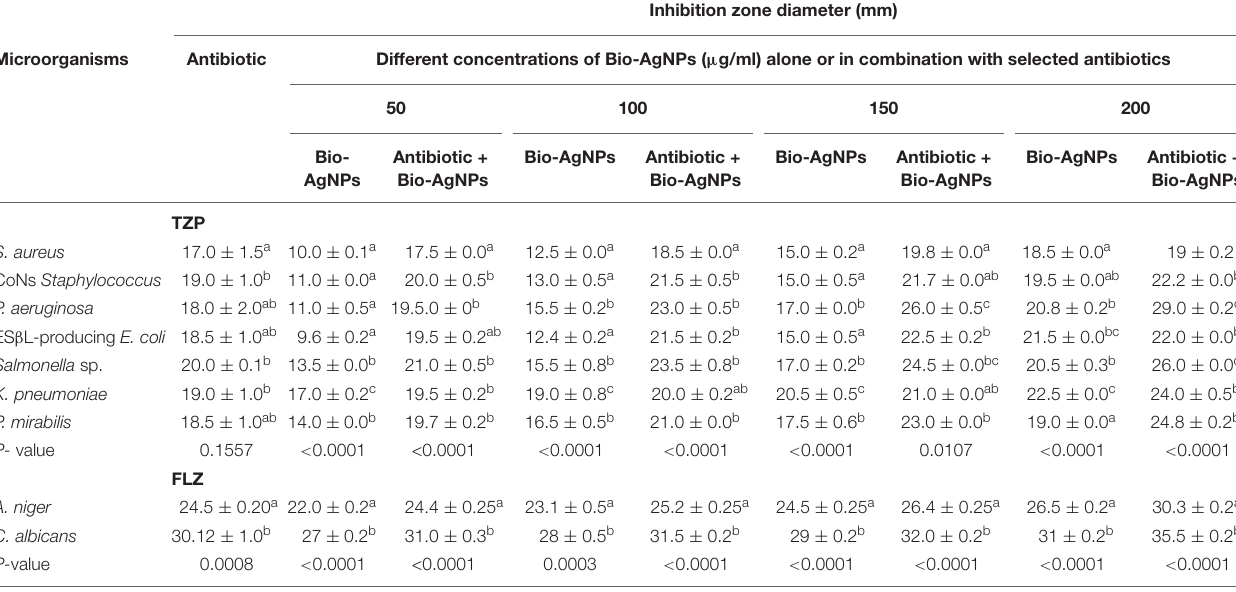
TABLE 2 | Performance of antibiotic alone, Bio-AgNPs alone, or their combination against various pathogenic microorganisms tested.